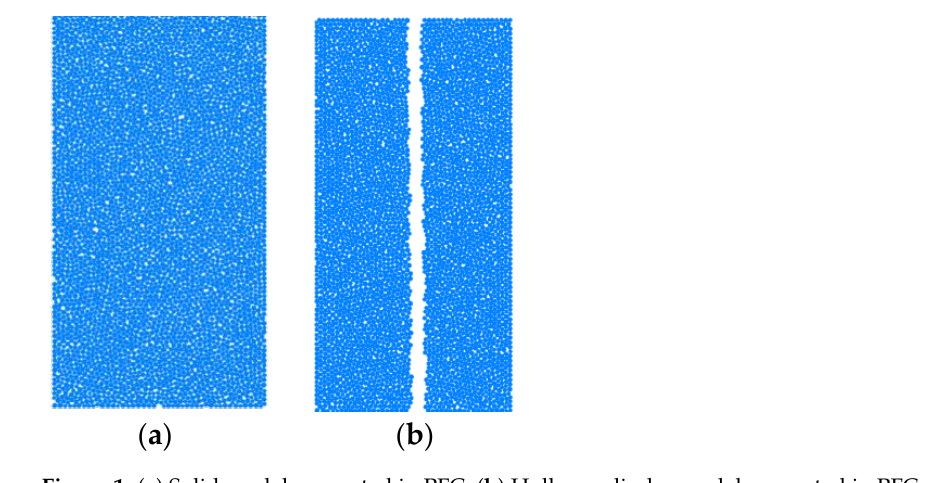
Figure 1. ( a ) Solid model generated in PFC. ( b ) Hollow cylinder model generated in PFC. The default procedure to set up a PFC2D model for numerical simulations involved following the four steps below proposed by Potyondy and Cundall